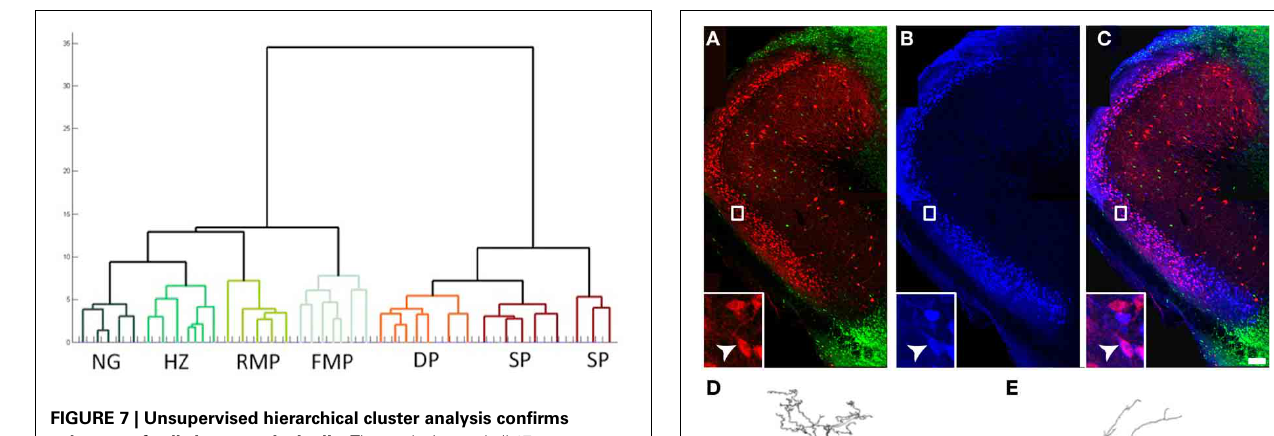
FIGURE 7 | Unsupervised hierarchical cluster analysis confirms subtypes of cells in pars principalis. The analysis used all 17 electrophysiological and four morphological properties to link similar cells. NG, neurogliaform; HZ, horizontal; RMP, regular multipolar; FMP, fast multipolar; DP, deep pyramidal; SP, superficial pyramidal.